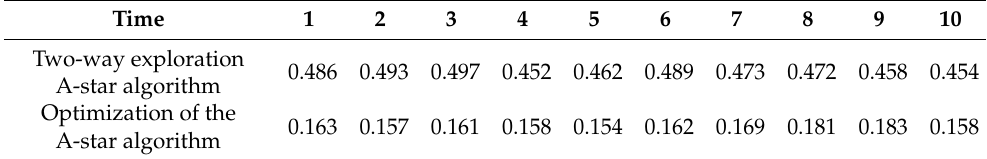
Figure 14. Optimized A-star algorithm vs. the bidirectional A-star algorithm. ( a , c ) The bidirectional A-star algorithm; ( b , d ) optimization of the A-star algorithm. Table 4. Comparison of path-planning times based on Figure 14a,b (unit: s).